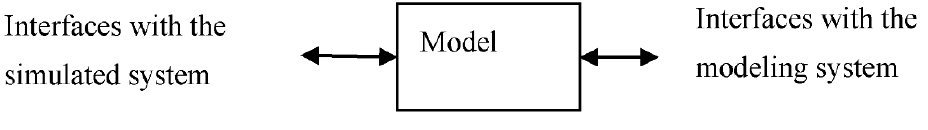
Figure 10. The Meta model